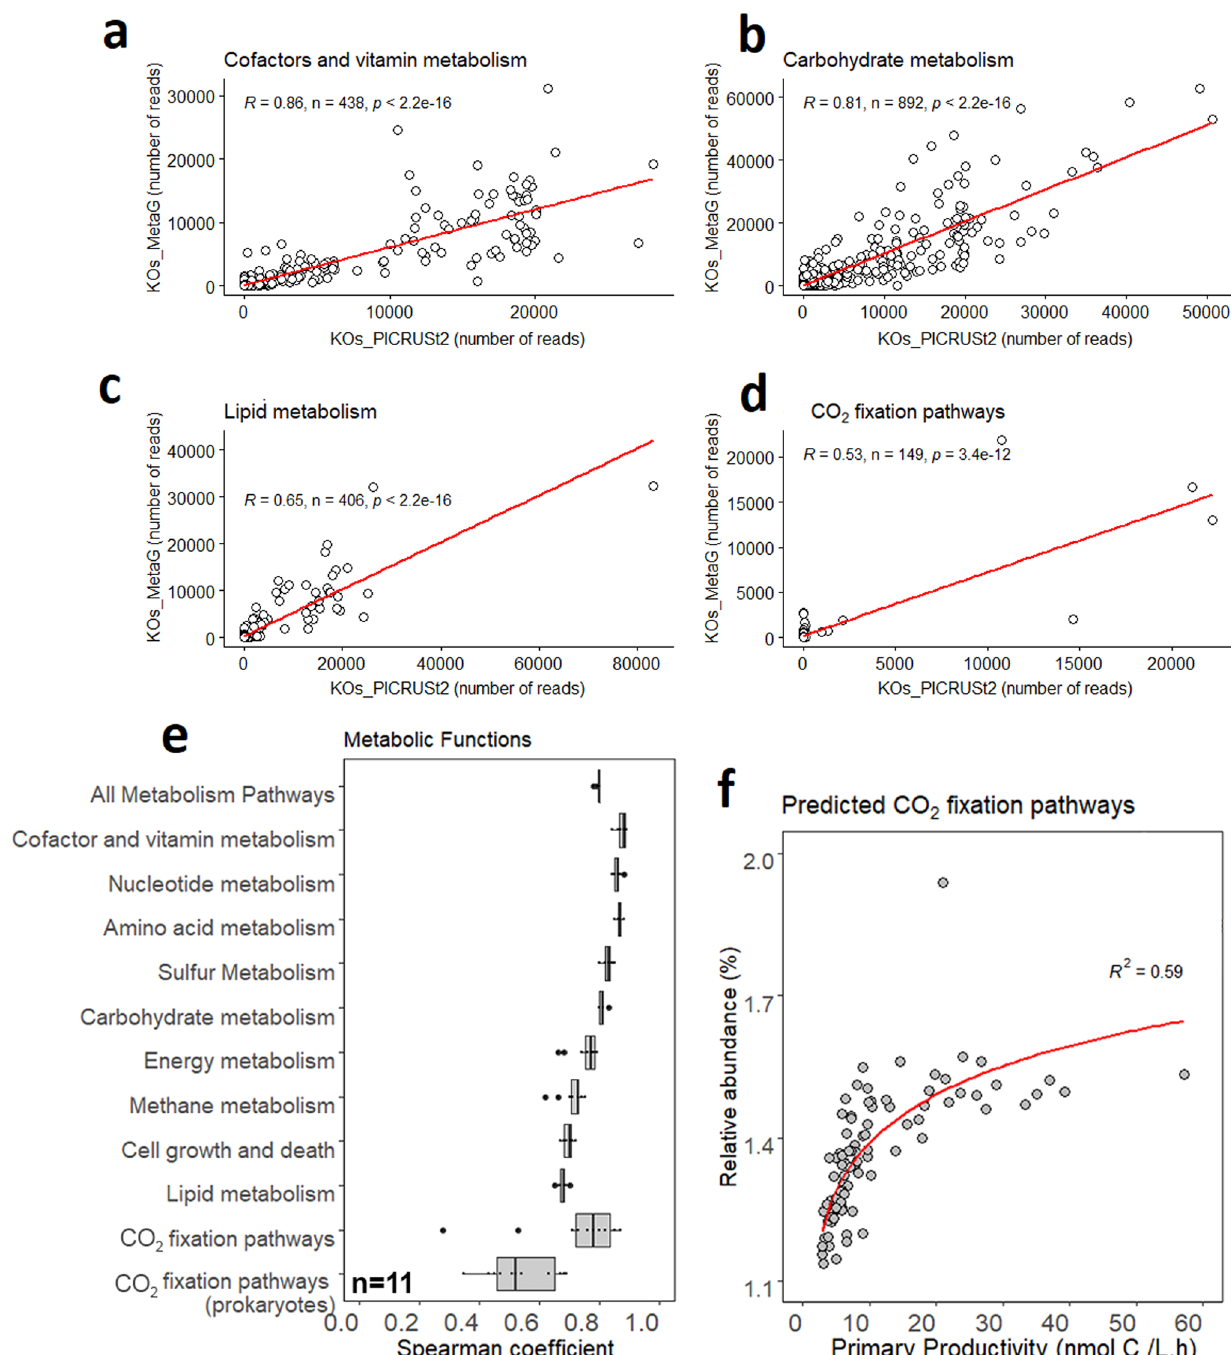
Fig. 2 Comparative analyses between the KEGG orthologs (KO) predictions from PICRUSt2 and the KOs pro fi led from corresponding shotgun metagenomes (MGS). Two-sided Spearman correlation coef fi cients (indicated as R on plots a – d for the station at 66 °S) between the number of assigned KO reads are shown for the following pathways: a cofactor and vitamin metabolism; b carbohydrate metabolism; c lipid metabolism; and d CO 2 - fi xation pathways. e Summary of the Spearman correlation coef fi cients between the predicted KO and MGS KO abundances for the 11 samples and for each metabolic function. Boxplots in e show median values (center line); the upper and lower quartiles are shown by box hinges; the whiskers present 1.5× interquartile range and the points outside the whiskers are plotted individually. Predicted PICRUSt2 pathways for CO 2 - fi xation and primary productivity correlation with an exponential order (red curve; ( f )). On average of 1.4 ± 0.9% (±SD) of the metagenome reads were